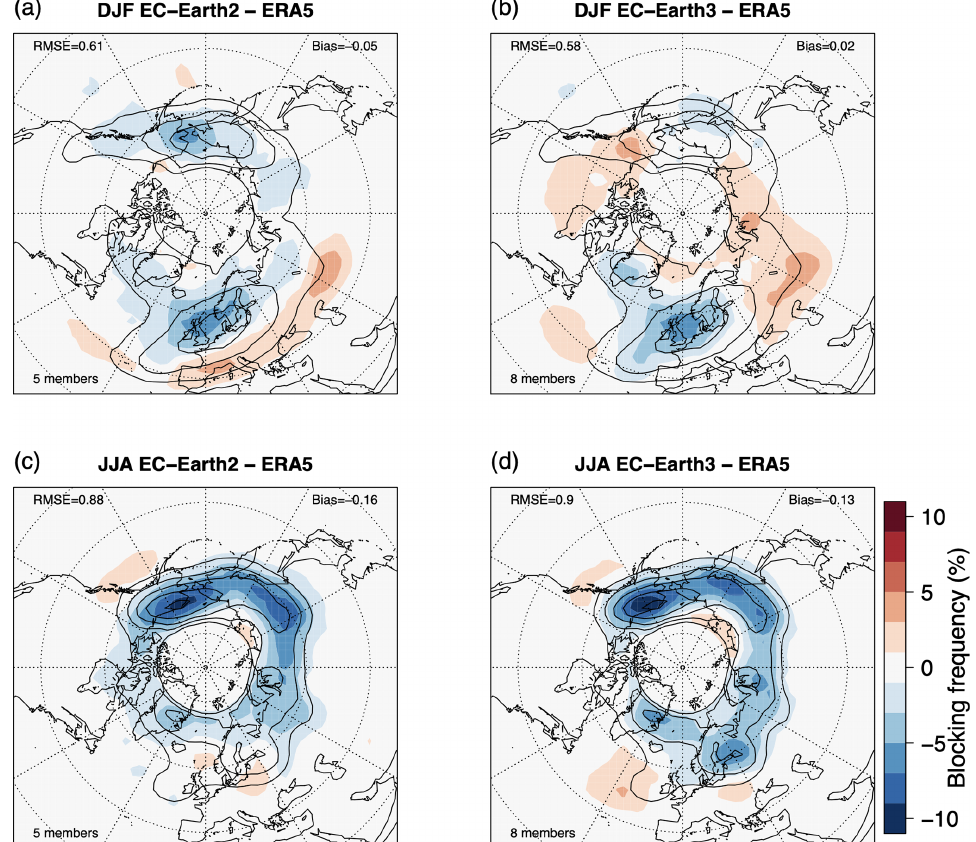
Figure 9. Biases for the blocking frequency according to the Davini and D’Andrea (2020) index for EC-Earth2 (a, c) and EC-Earth3 (b, d) against ERA5 reanalysis over the 1980–2010 period. Contours show the ERA5 climatology. Panels (a) and (b) are winter, and panels (c) and (d) are summer. Root mean square error, mean bias, and the number of ensemble members used are reported in each panel.